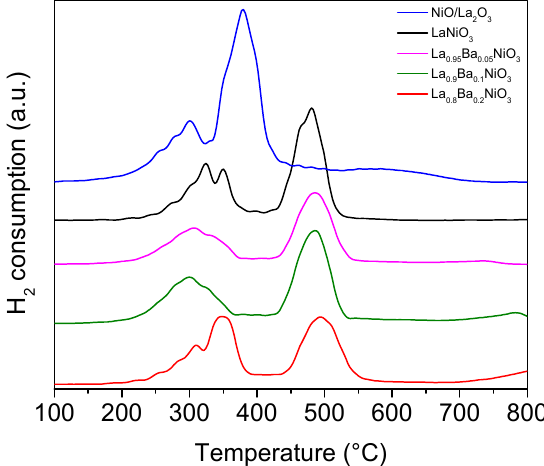
Figure 5. Temperature programmed reaction profiles of the samples La 1-x Ba x NiO 3 and NiO/La 2 O 3 .